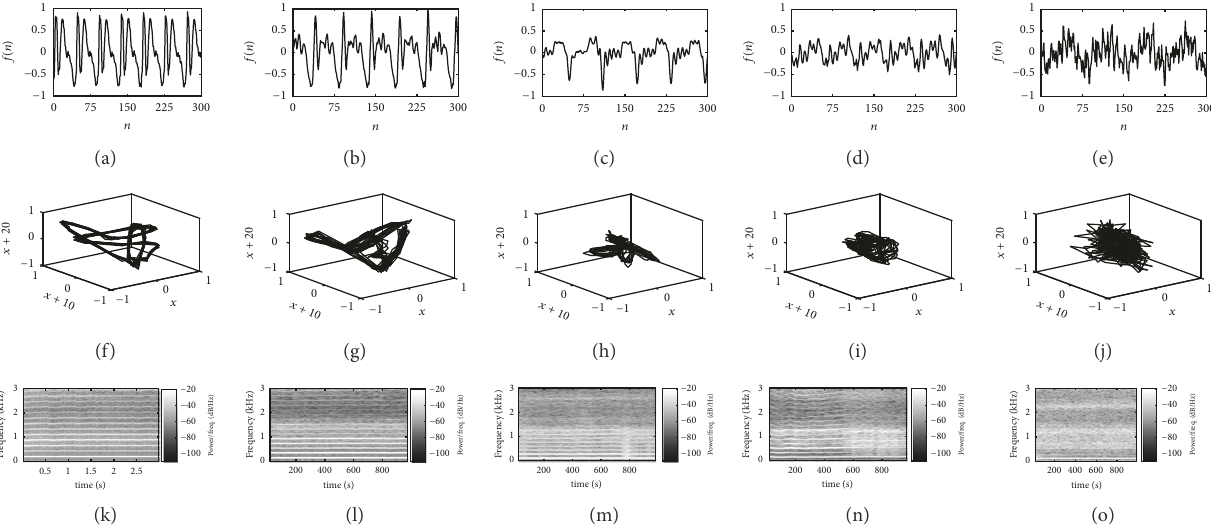
Figure 1: Time series, state space reconstruction, and spectrogram of normal and pathological voices. First column: normal voice; second column:pathologicaltype 1 voice;thirdcolumn:pathologicaltype 2 voice;fourthcolumn:pathologicaltype 3 voice;fifthcolumn:pathological type 4